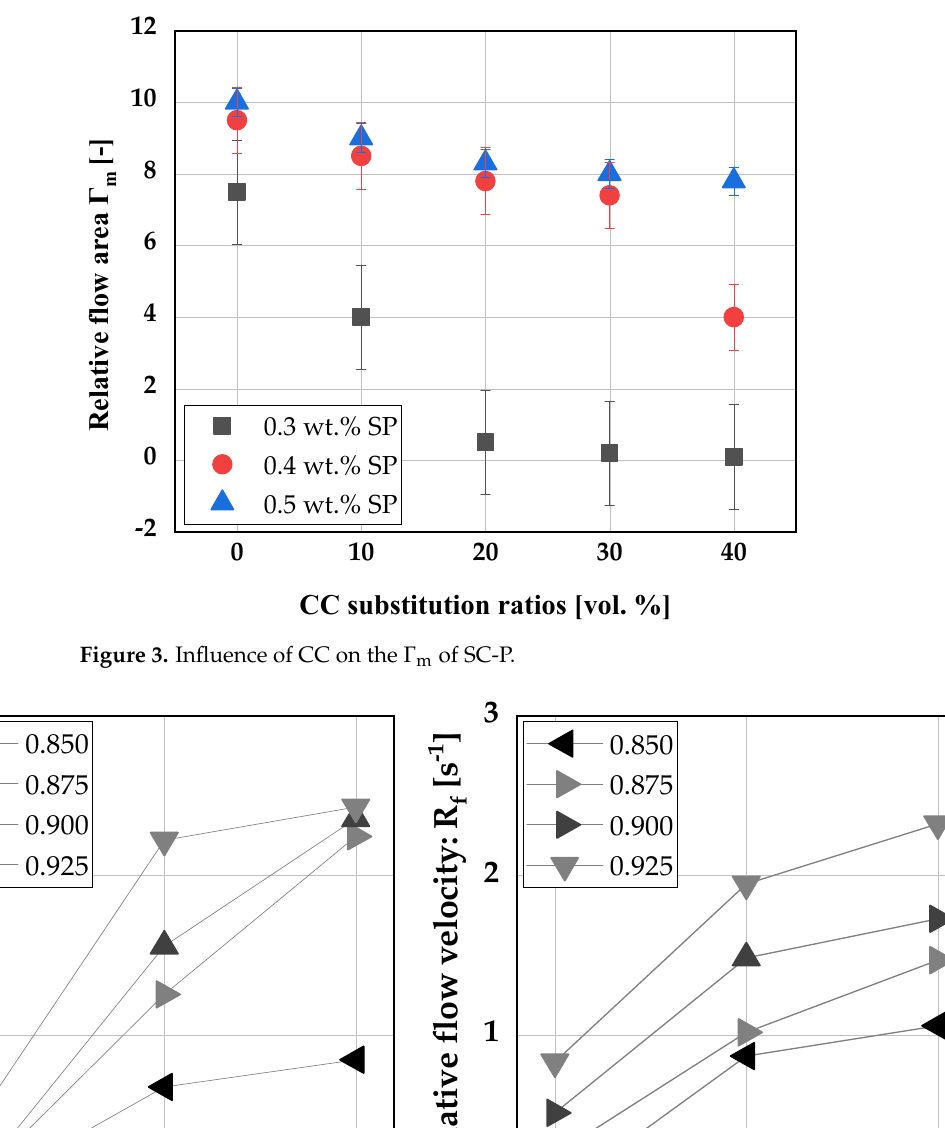
Figure 4. Г m and R f of SC-M with varying V w /V p ratios of 0.850 to 0.925 and constant V s = 0.4.